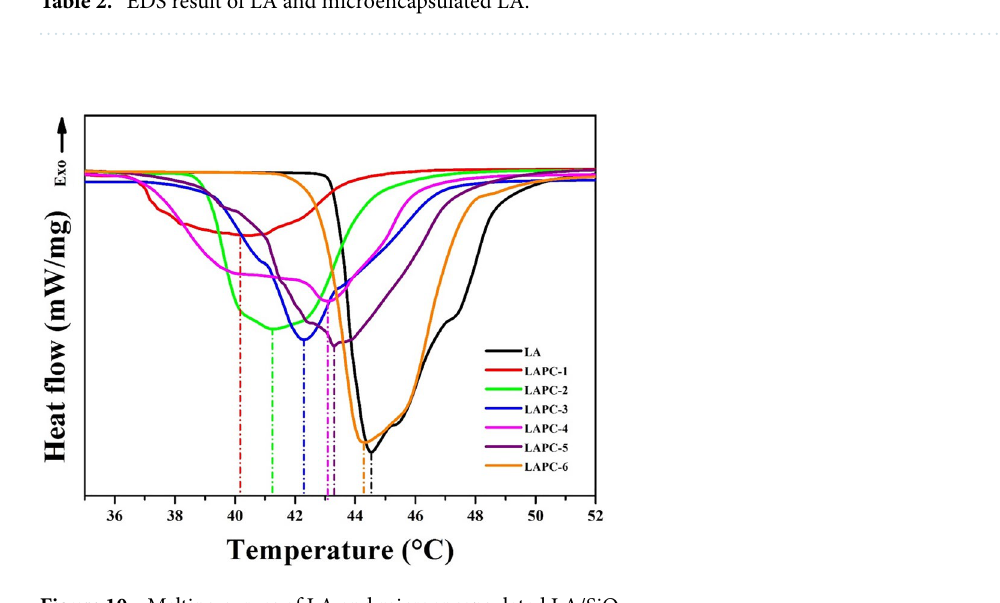
Figure 10. Melting curves of LA and microencapsulated LA/SiO 2